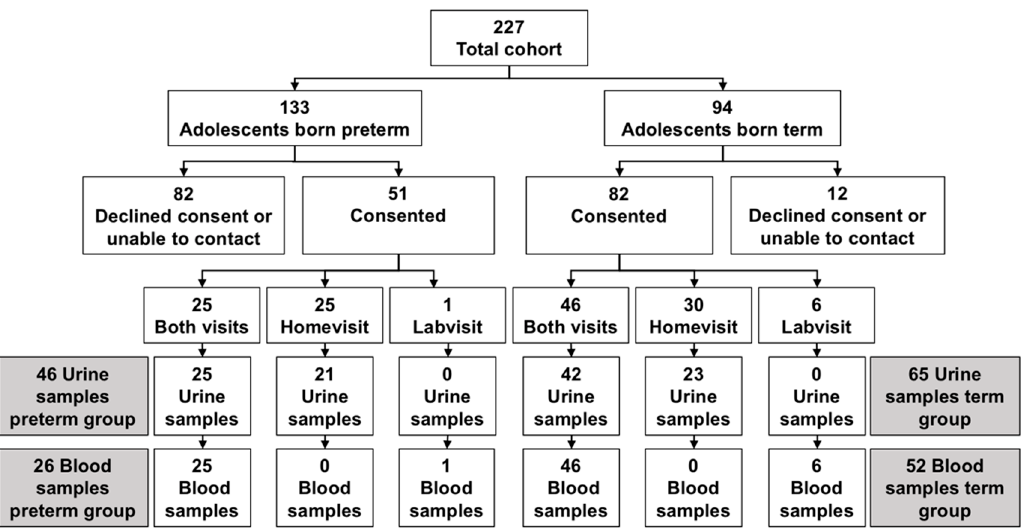
Figure 1. Participant flow diagram of recruitment and procuring of urine and blood samples from the original cohort.